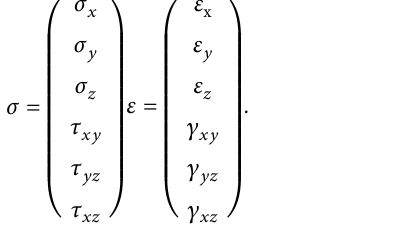
Figure 2: Maskless scanning plasma etching processing unit.